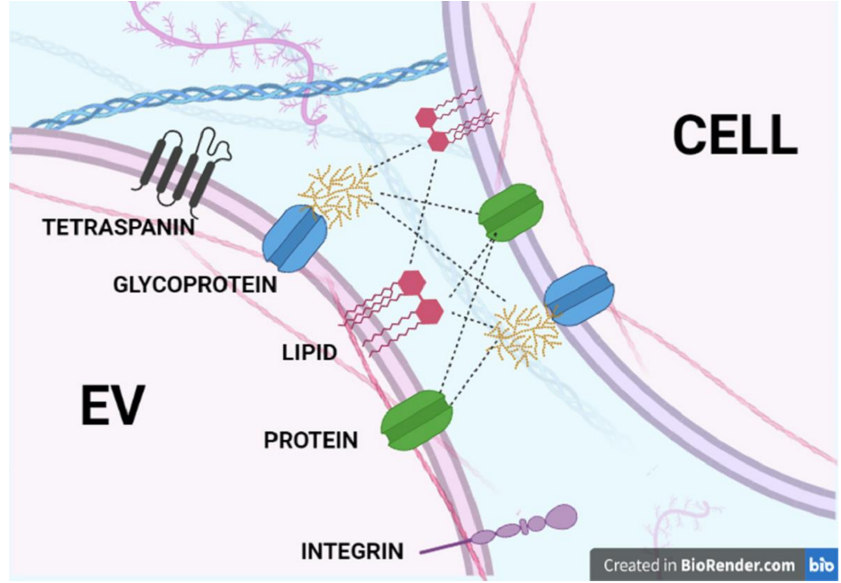
Figure 1. Possible interactions between EV membrane surface molecules and their counterparts in recipient cells. Dashed lines indicate all possible combinations of putative interactions. Protein include any PTM